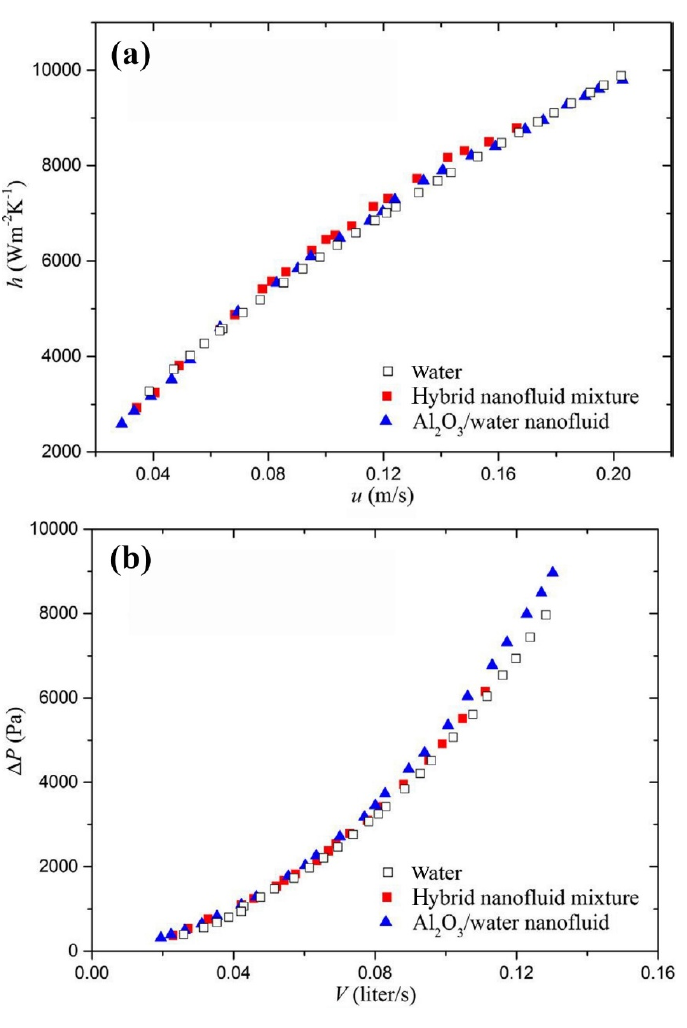
Figure 14. Variation of the ( a ) convective heat transfer coefficient, and ( b ) pressure drop versus fluid velocity for the three different fluids. Reproduced with permission from [185]. Elsevier, 2016.